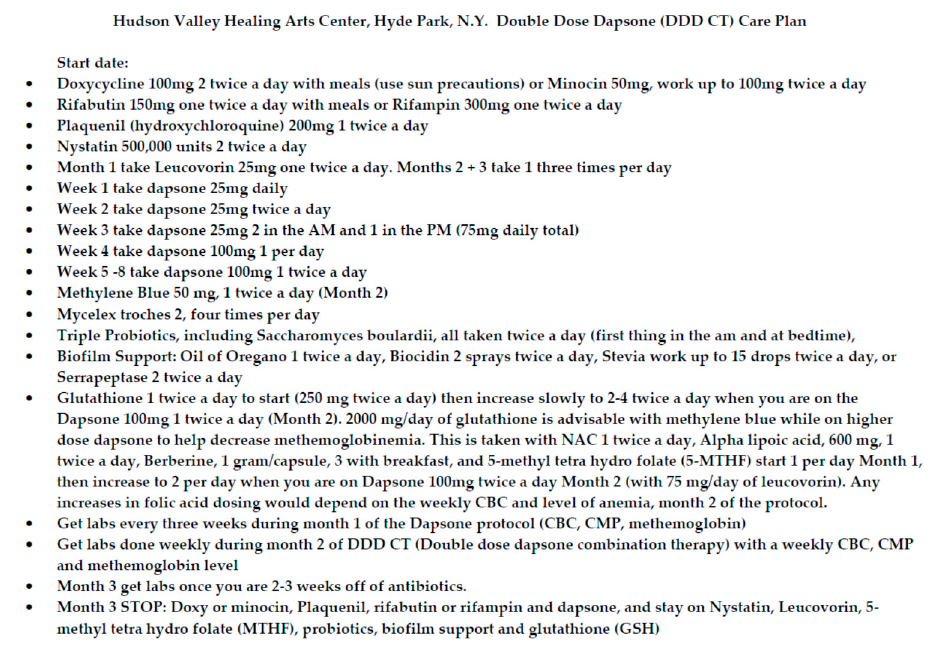
Figure 1. Double-dose dapsone combination therapy (DDD CT) patient care plan .